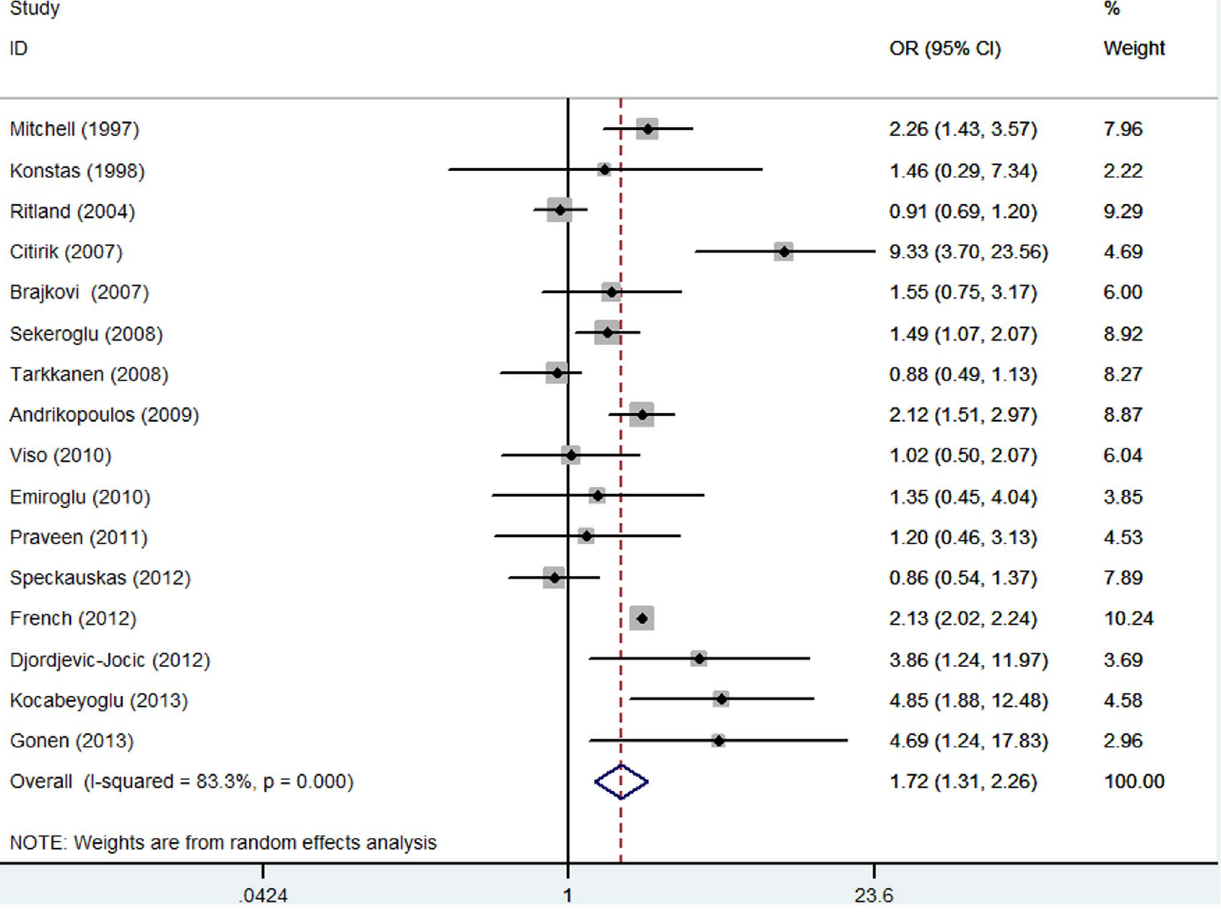
Figure 2. Random-effects meta-analysis of studies that examined PEX and risk of vascular disease.